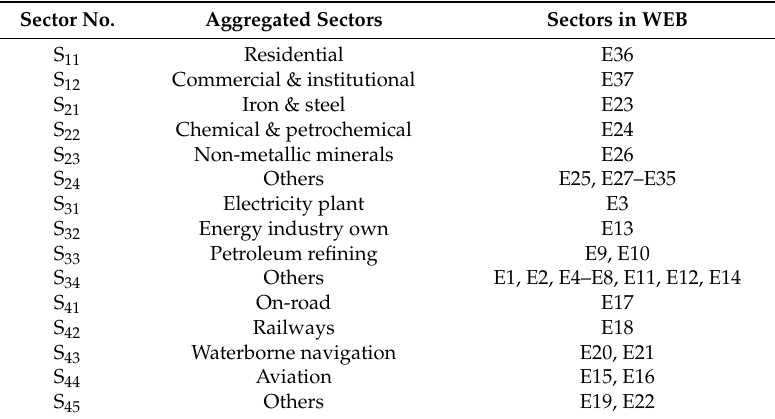
Table 1. Aggregation of emission sectors.